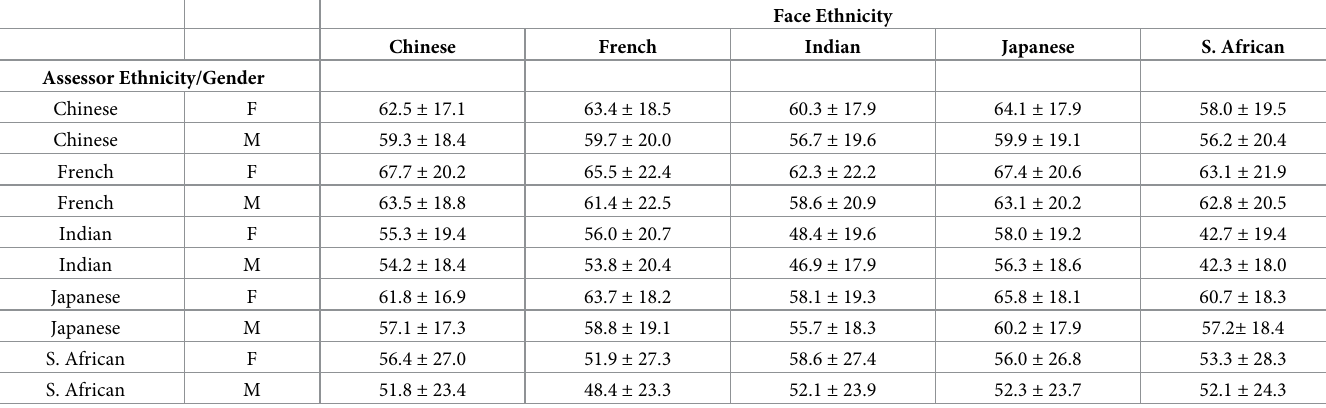
Table 6. Descriptive statistics of health assessments, separately for assessor ethnicity and gender, and participant (“face”) ethnicity (mean ± SD).